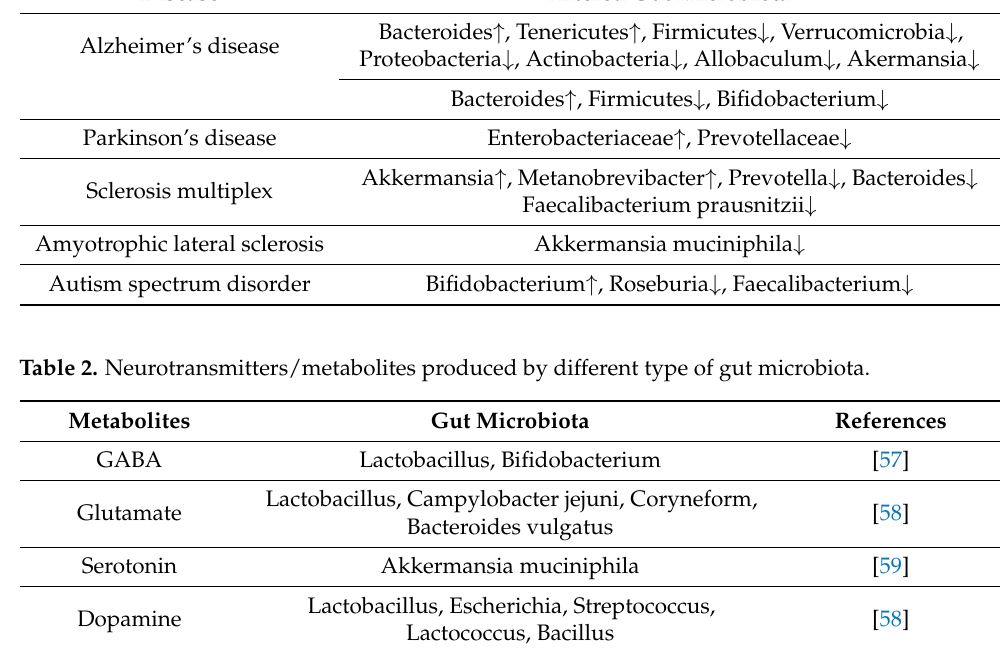
Table 1. Relation between altered gut microbiota composition and particular disorder of the nervous system ( ↑ = increased, ↓ = decreased). Disease